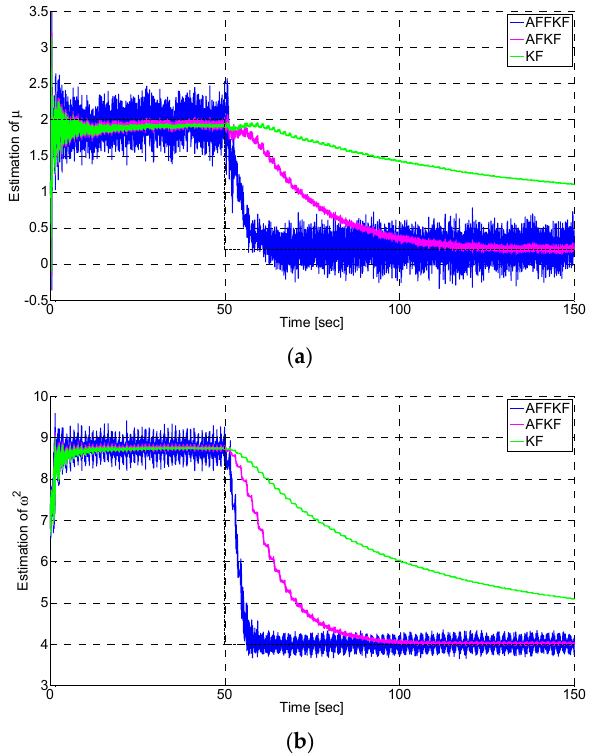
Figure 8. Results of estimation of abrupt fault parameter for van der pol model: ( a ) friction coefficient, ( b ) natural frequency.